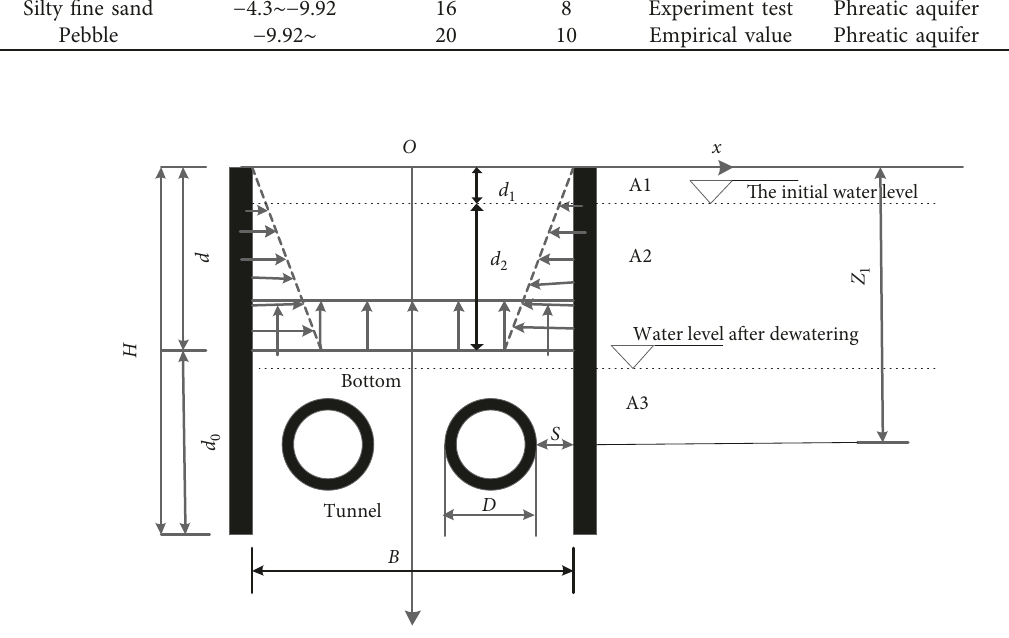
Figure 3: The front of view of mechanical model.